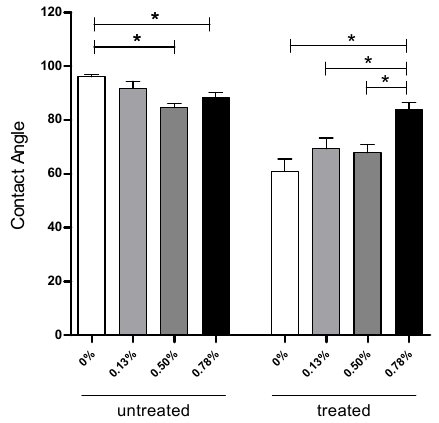
Figure 1. Summary of the apparent water-in-air contact angle for scaffolds containing different pristine graphene concentrations untreated and treated with NaOH 5M. * Statistical evidence ( p < 0.05) analysed with a one-way ANOVA and Tukey’s post-hoc test.